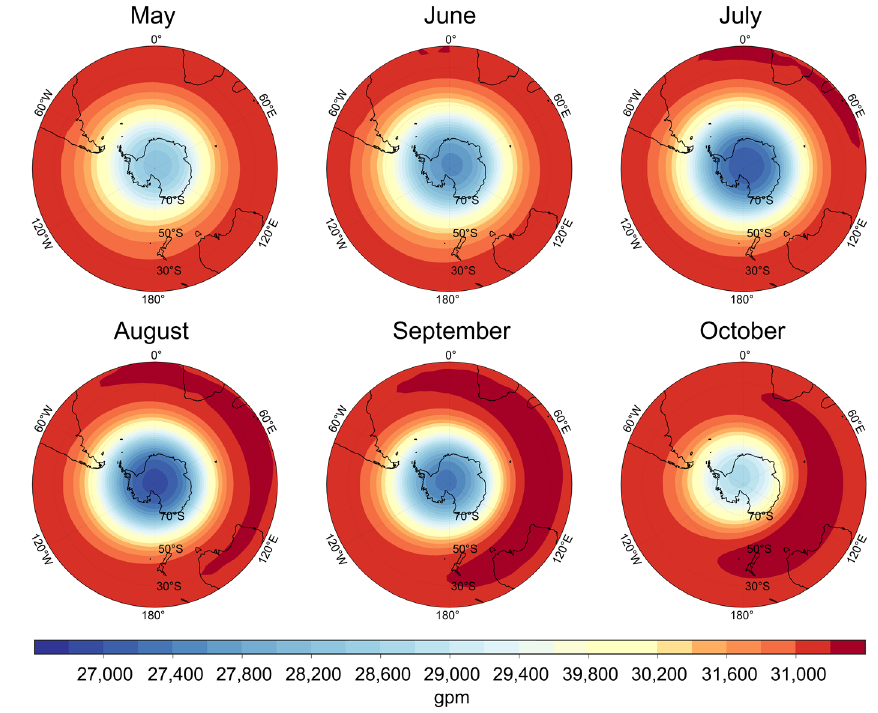
Figure 8. Mean geopotential height at 10 hPa over the period 1950–2005 from May to October. Contour interval is 200 gpm. The outermost latitude is 20° S.